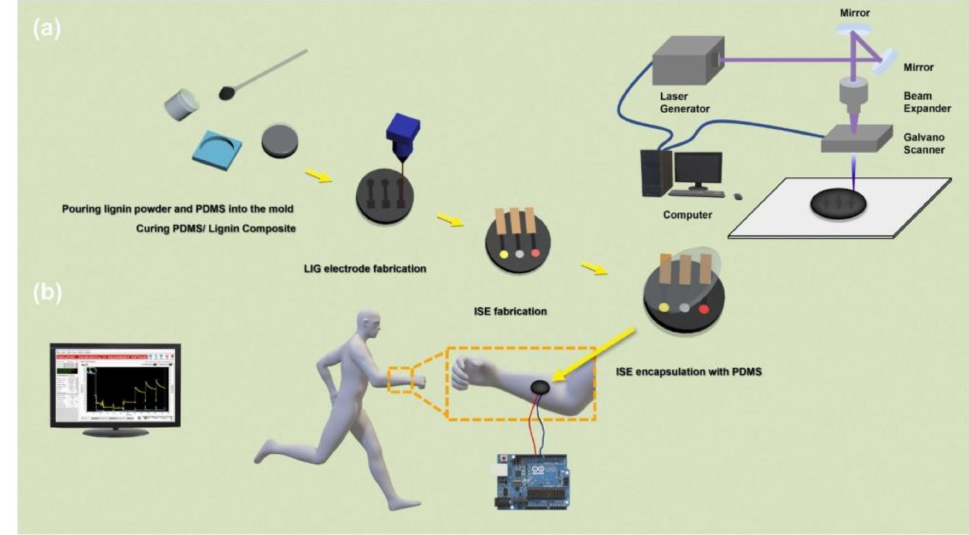
Figure 32. ( a ) Schematic representation of the LIG-based sensor platform’s manufacturing process. ( b ) An illustration of the sensor platform mounted to the wrist and the results of such sensing. (Reproduced from [576] under common